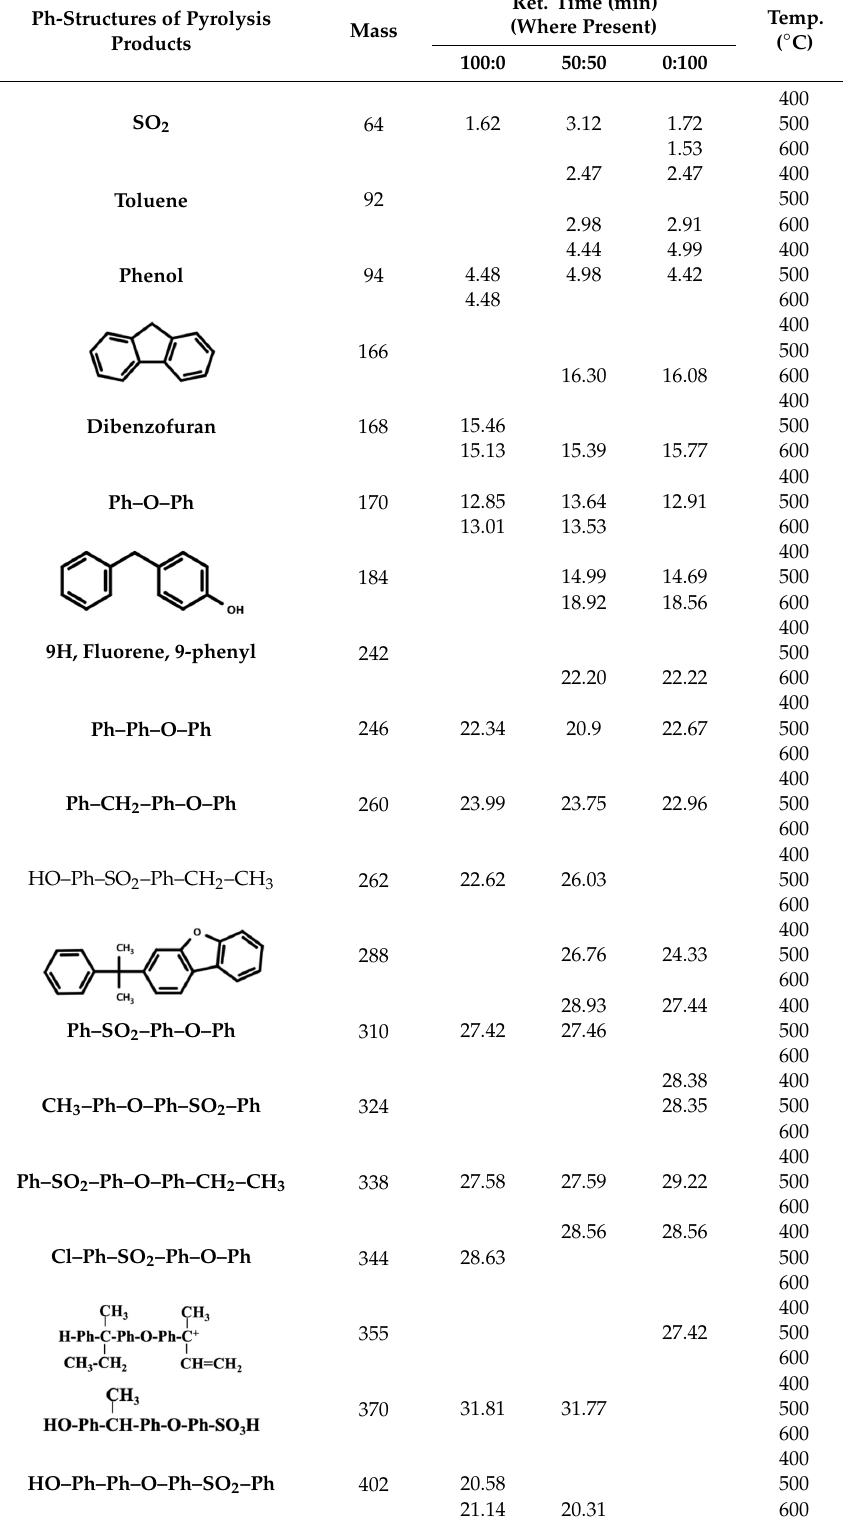
Figure 12. Py-GC/MS pyrograms P(ESES)-co-(ESDPA) 50:50 copolymer recorded at ( a ) 400, ( b ) 500 and ( c ) 600 °C. Table 4. Structural assignments of the most important pyrolysis products detected by stepwise Py-GC / MS of the poly(ether sulfones).